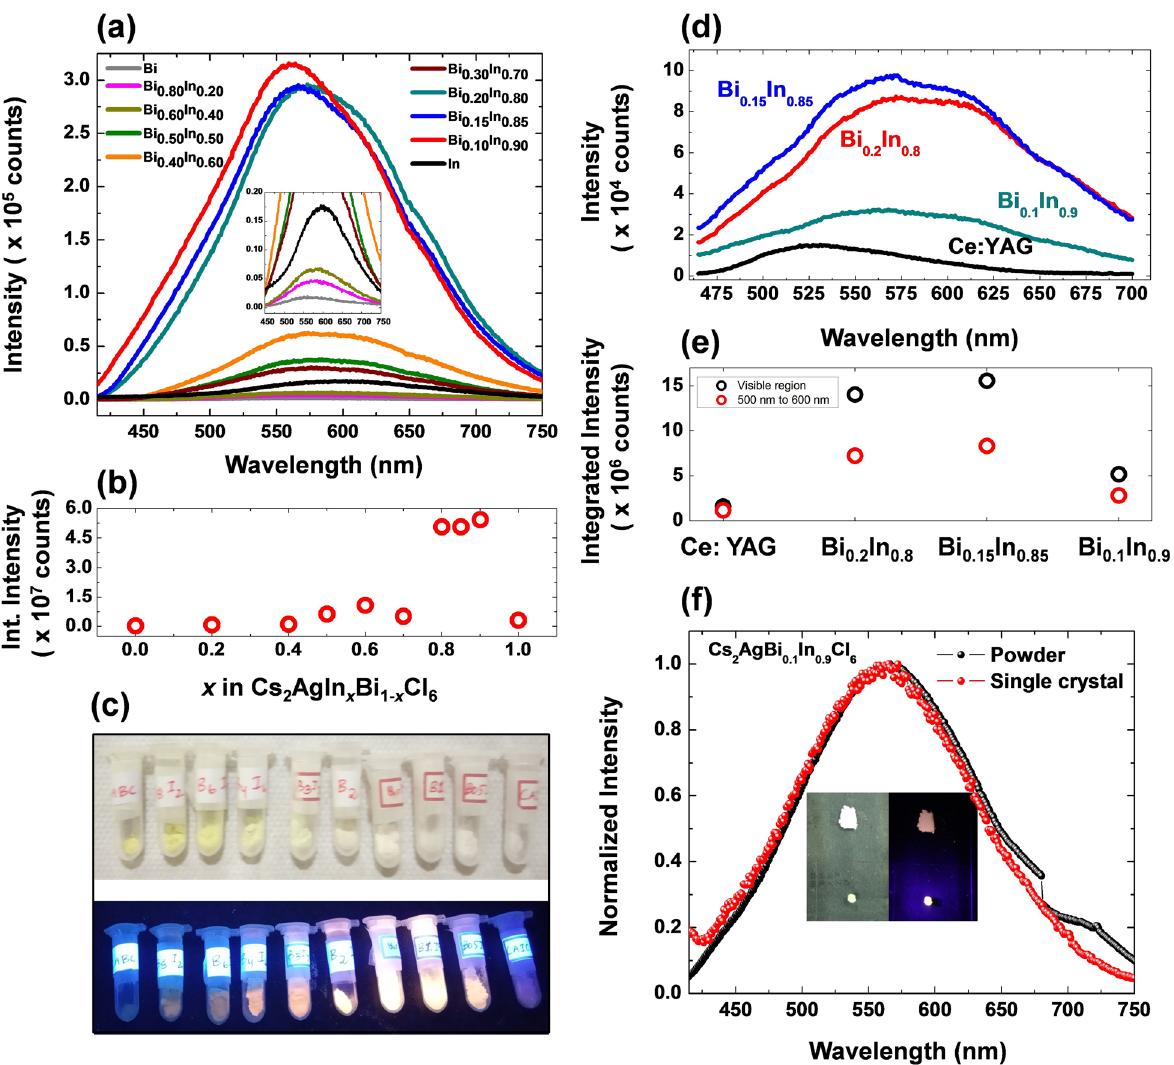
Fig. 3 Photoluminescence properties of Cs 2 AgIn x Bi 1 − x Cl 6 compounds. a Photoluminescence spectra, and ( b ) integrated photoluminescence intensity of Cs 2 AgIn x Bi 1 − x Cl 6 powders (excitation wavelength-380 nm). Note: The XRD and Raman spectra of the samples with x = 0.7 – 0.95 are given in Supplementary Fig. 15 and Supplementary Fig. 16. c Photograph of Cs 2 AgIn x Bi 1 − x Cl 6 compounds, in which the top image shows the samples under room light and bottom images show the samples under 365 nm wavelength UV irradiation. d Photoluminescence spectra of Ce:YAG, Bi 0.20 In 0.80 , Bi 0.15 In 0.85, and Bi 0.10 In 0.90 compounds excited at 430 nm wavelength for relative quantum yield measurements. e Photoluminescence-integrated intensity for Ce:YAG, Bi 0.20 In 0.80 , Bi 0.15 In 0.85, and Bi 0.10 In 0.90 compounds, where integrated intensity for covering the entire visible region is given in hollow black circles and integrated intensity for wavelength between 500 and 600 nm is given in hollow red circles. f Normalised photoluminescence spectra of Bi 0.10 In 0.90 compound for a single crystal and powder compounds, where the inset photograph depicts the samples under room light and irradiation at 375 nm wavelength. The crystals are nearly 2 mm in